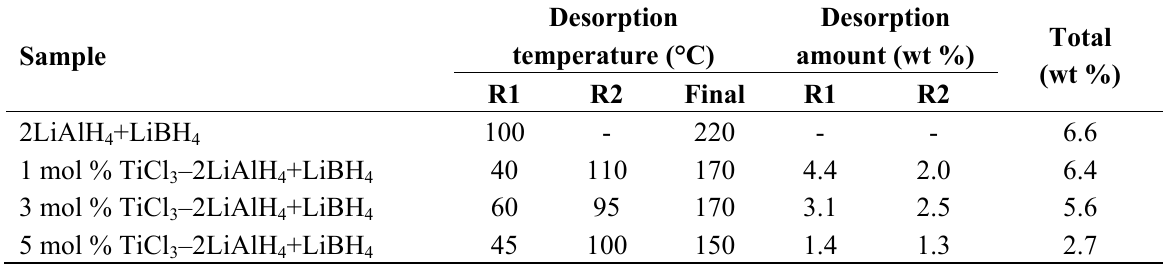
+LiBH ; ( b ) 1 mol % 4 4 +LiBH ; and ( d ) 5 mol % 4 4